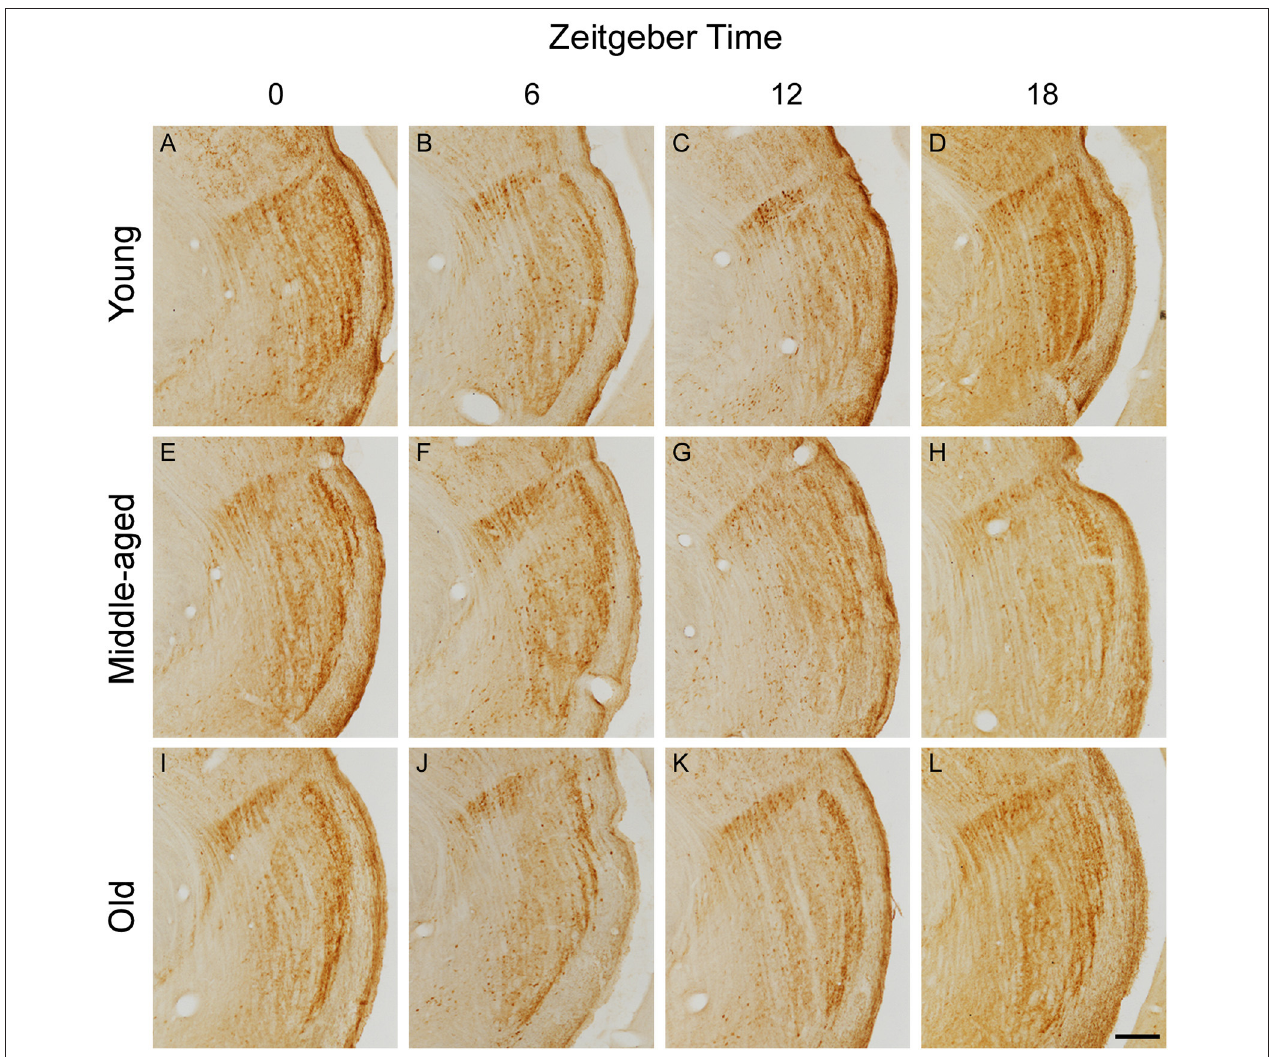
FIGURE 2 | Photomicrographs of CR immunolabeled histological sections containing the IGL, vLGNe, and vLGNi in animals from distinct age and ZT groups. CR sections are obtained after brain perfusion at ZTs 0 (dark/light phase), 6 (light phase), 12 (light/dark phase), and 18 (dark phase) from young (A–D) , middle-aged (E–H) , or old (I–L) animals. Scale bar = 225 µ